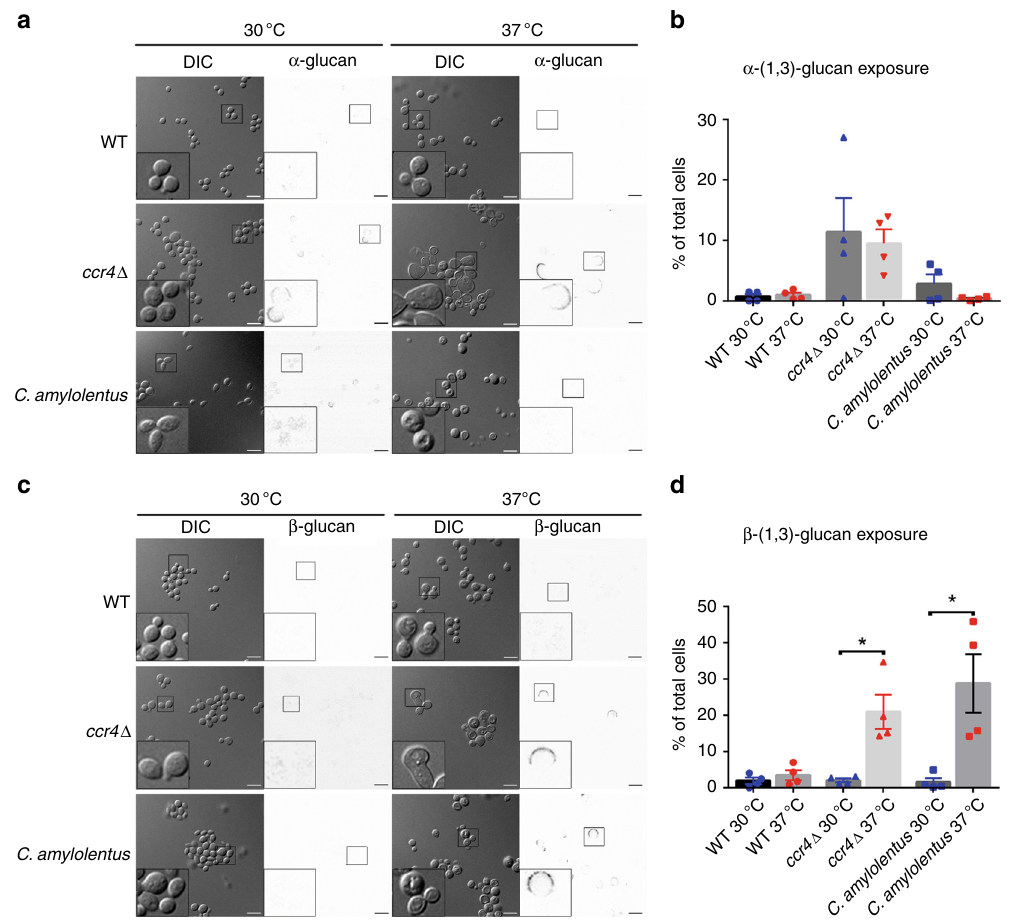
Fig. 5 mRNA decay prevents unmasking of cell wall glucans at 37 °C. Wild-type C. neoformans , the ccr4 Δ mutant, and wild-type C. amylolentus were grown at 30 °C or 37 °C and stained with α -(1,3)-glucan antibody MOPC104e ( a , b ) or anti- β -(1,3)-glucan antibody ( c , d ). Cells were visualized by fl uorescence microscopy ( a , c ). Scale bar = 10 µ m. Insets show magni fi ed views of cells outlined in boxes. Glucan exposure was measured by fl ow cytometry ( b , d ). Graphs are representative of the mean percentage of cells ± s.e.m. ( n = 4) exposing α -(1,3)-glucan ( b ) or β -(1,3)-glucan ( d ), and signi fi cance was determined by Kruskal – Wallis and Dunn ’ s test post hoc. Source data are provided as a Source Data fi